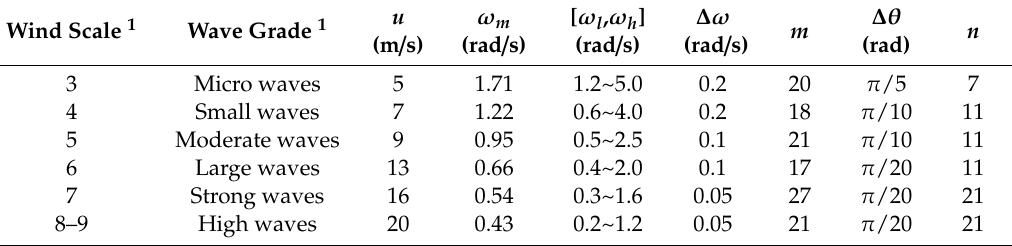
Table 1. Simulation parameters of the three-dimensional waves under typical wind speeds. Wind Scale